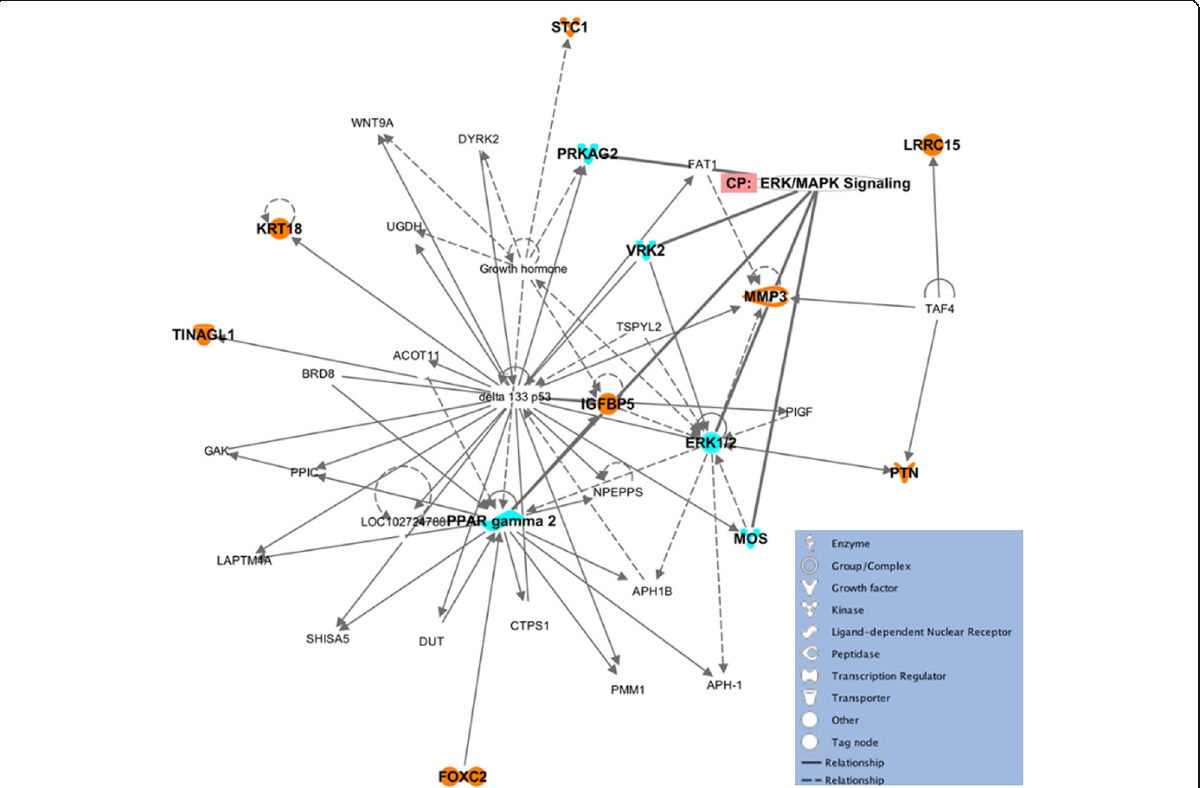
Fig. 5 Ingenuity Pathway Analysis (IPA) of network of eight DE genes. The eight genes that were found by the intersection shown in Fig. 3 were input into IPA to generate a network diagram with the most plausible connections to each other, and to additional genes in the IPA Knowledge Base. The eight genes of interest are highlighted in orange. A maximum of thirty-five genes are shown in the network for readability. The ERK/ MAPK pathways genes found in this network are highlighted in